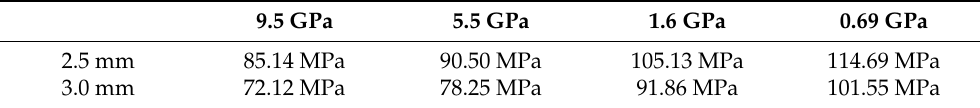
Figure 14. Cortical bone von Mises stress (3.0 mm). Table 6. Cortical bone 2.5 mm/3.0 mm (axial force) von Mises stress values.